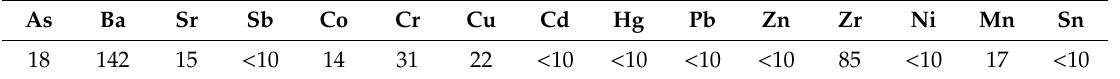
Table 6. ICP-OES trace elements results (mg / kg).